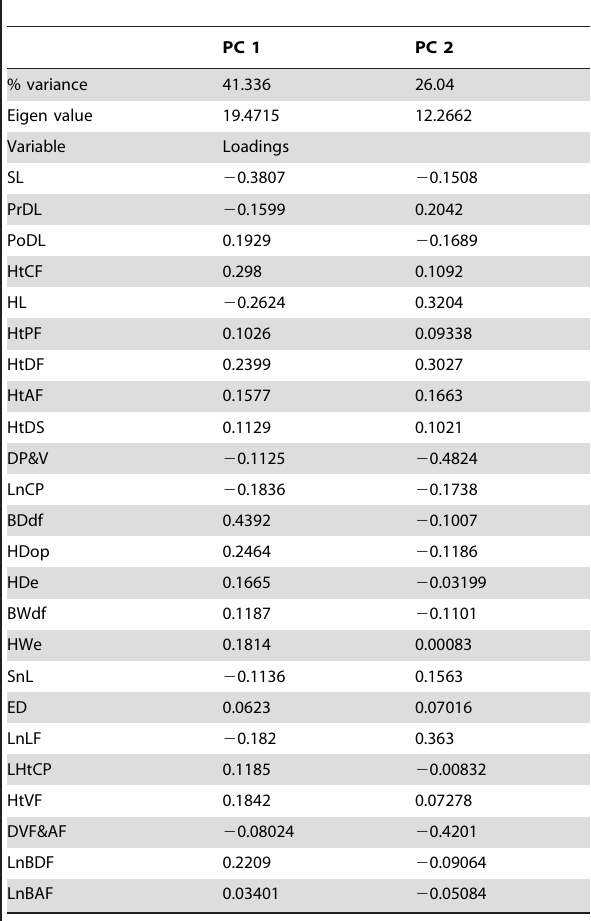
Table 2. Summary of PCA on 24 morphometric measurements of 28 samples within 4